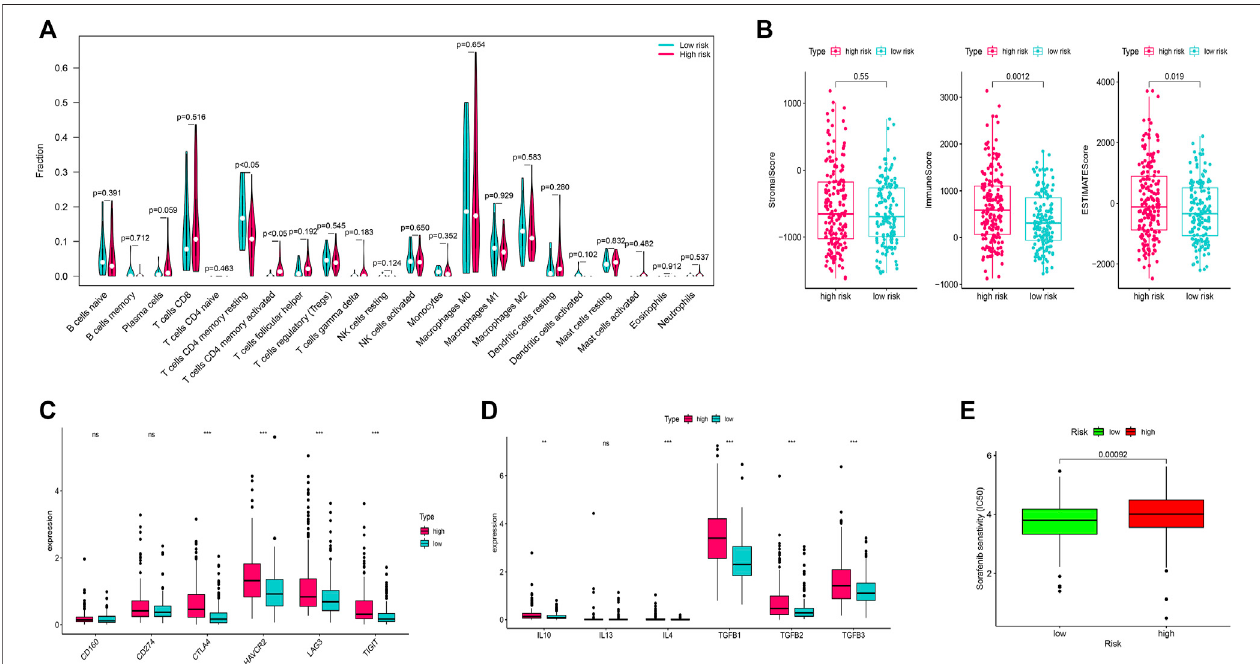
FIGURE 5 | Immune in fi ltration analysis and chemotherapy sensitivity. (A) Relation of the immune cells with a risk score. (B) Immune, stromal, and ESTIMATE scores in the high and low-risk groups. (C) Relation of the immune checkpoints with risk-score. (D) : Relation of the immune-suppressive cytokines with a risk score. (E) Sorafenib sensitivity in high-risk and low-risk